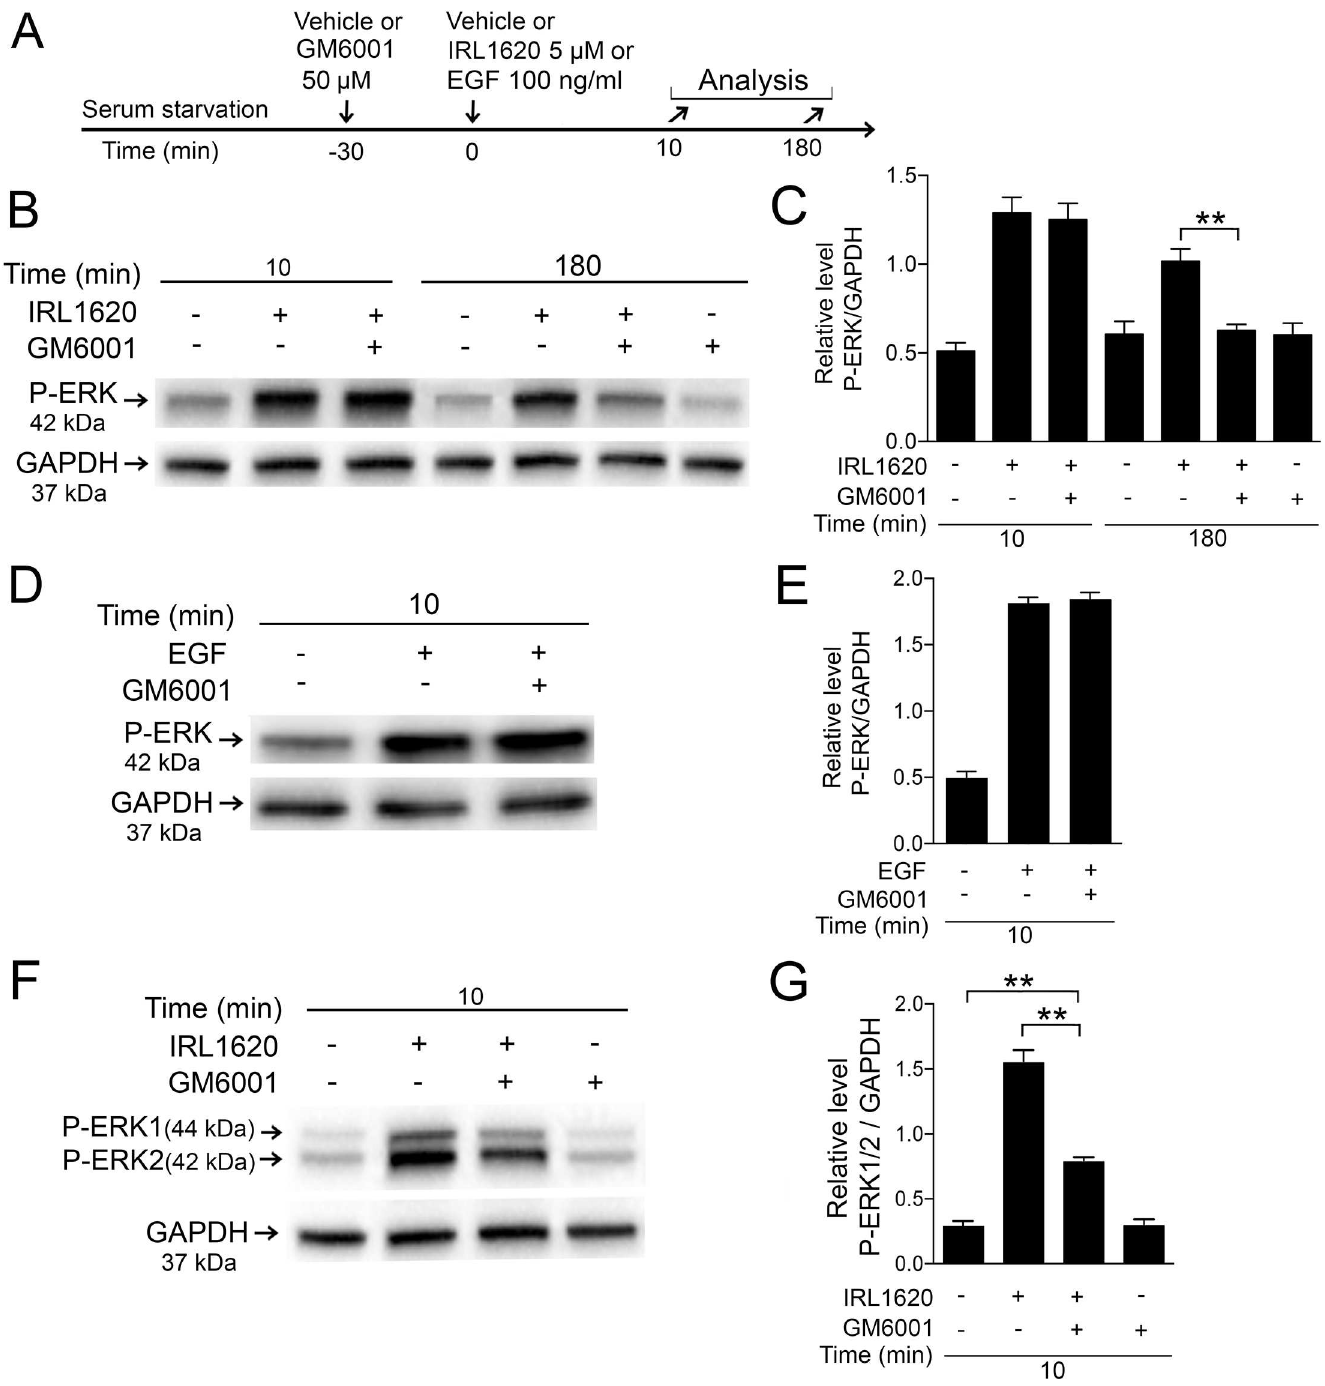
Fig 9. Effect of MMPs inhibitor GM6001 on IRL1620- induced P-ERK1/2 in primary chicken Mu¨ller cells and the human MIO-M1 cell line. Serum- starved primary chicken Mu¨ller cells and human MIO-M1 cells pretreatedwith 50 μ M GM6001 or control (vehicle) for 30 min followedby treatment with 5 μ M IRL1620or vehicleswere analyzed.(A) Experimental outline. The MIO-M1 cells were only analyzedat 10 min becausethe peak at 180 min is not present. Western blot analysesof P-ERK levels in (B) chicken Mu¨ller cells treated with IRL1620and/or GM6001 and (D) EGF and/or GM6001. EGF- treatment was only analyzedat time point 10 min. (C, E) Bar graphs with densitometry of P-ERK levels normalized by GAPDH levels. Western blot analysisof P-ERK1/2 levels in (F, G) humanMIO-M1 cells treated with IRL1620and/or GM6001. (G) Bar graph with densitometry of P-ERK1/2 levels normalized by GAPDH levels. Bar graphs are mean ± SEM, n = 3 ( ** P < 0.001) analyzedby one-wayANOVA and Tukey’s post hoc test. Significance is only indicatedfor the comparisons: IRL162010 min-IRL1620+GM600110 min, and IRL1620180 min-IRL1620+GM6001180 min.